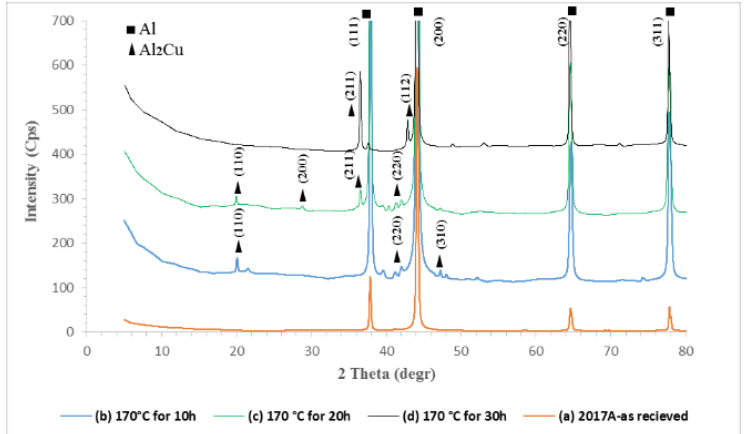
Fig. 3. X-ray diffraction pattern of 2017A alloy under aging treatment at 170 °C for: (a): as-received material, (b): 10 h, (c): 20 h, and (d): 30